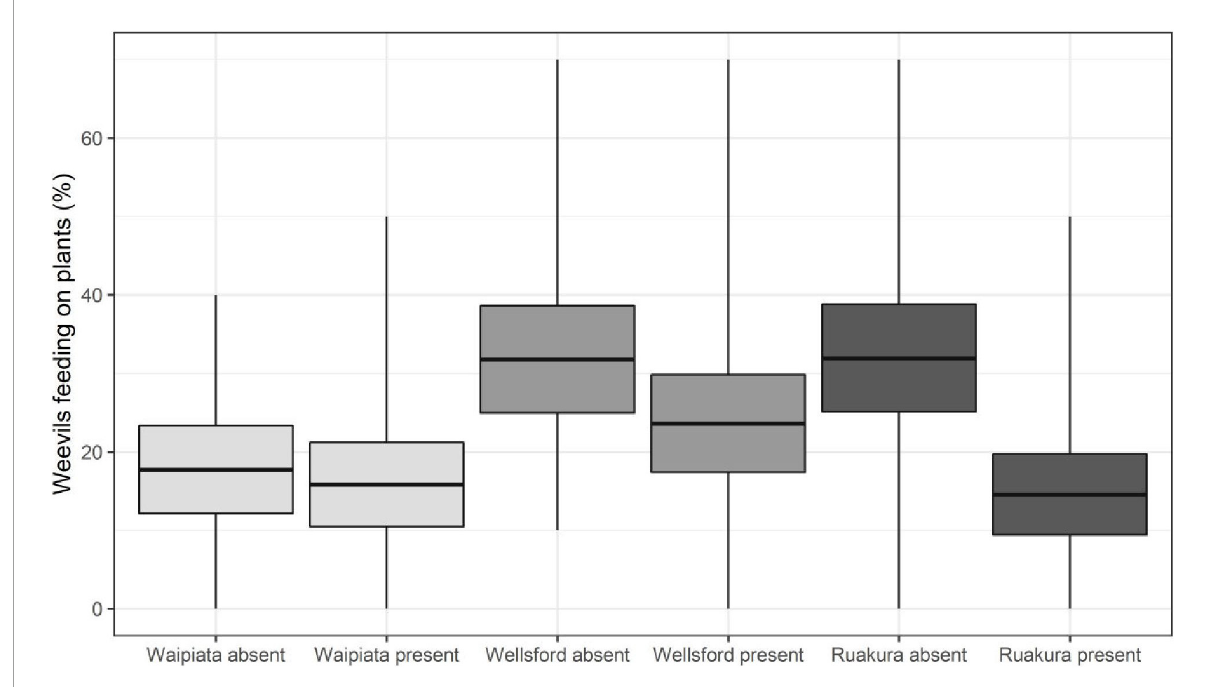
FIGURE4 The late-season weevil experiment . Mean percentages of Listronotus bonariensis feeding in the absence or presence of Microctonus hyperodae. The weevils were collected from the Southern Region (Locality: Waipiata) and the Northern Region (Localities: Wellsford and Ruakura) of New Zealand. Rectangles show the mean (central line) and 95% CL, and tails show the